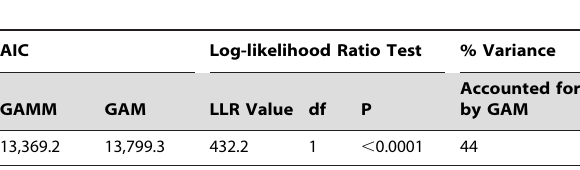
Table 2. GAMM and GAM-equivalent standardized catch rate model for live seabirds fits to the Hawaii longline swordfish fishery observer program